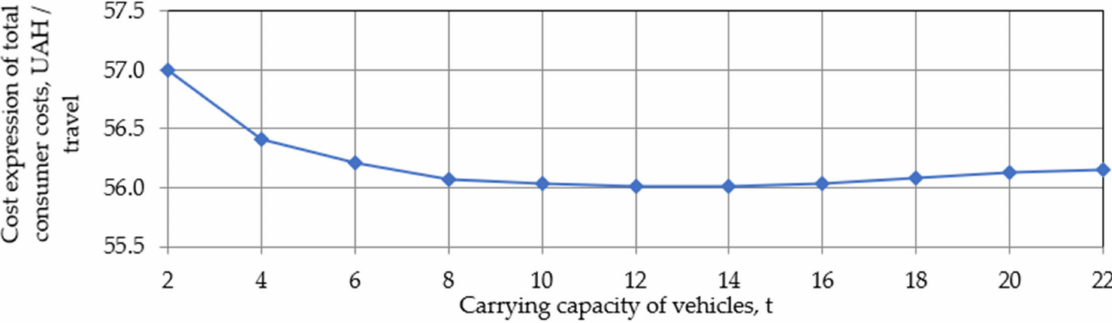
Figure 12. Changing the value of the total costs of end-consumers depending on the load capacity of